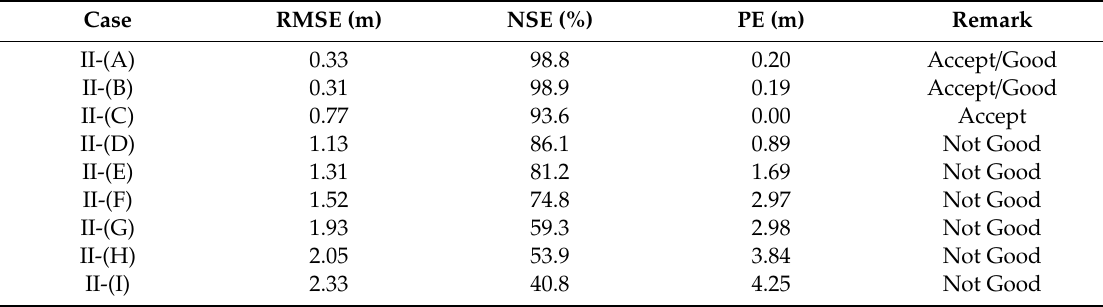
Table 10. Summary of the accuracy for various leading times in Scenario II (Period: 5–7 July 2016 about 50 h, w 1 = 0.6 & w 2 = 0.4).